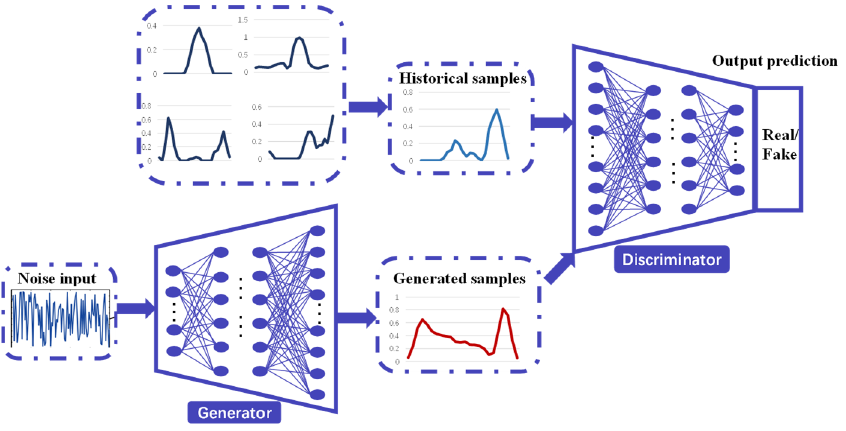
Figure 9. The architecture of GAN used for wind/solar scenario generation. Algorithm 1. Pseudo-code of